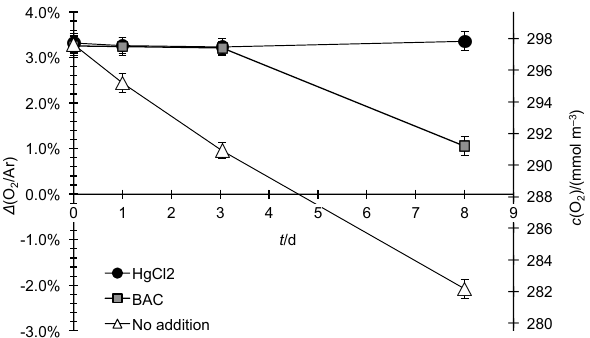
Figure 2. Biological oxygen supersaturation (cid:49) (O 2 / Ar) and corre- sponding oxygen concentration during TS2 (April 2010), for sam- ples without treatment (white triangle), BAC-treated (grey square) and HgCl 2 -treated (black circle). Error bars include the day-to-day calibration uncertainty.